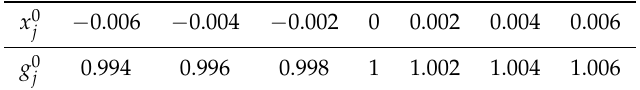
Table 3. Monotone data set of values.